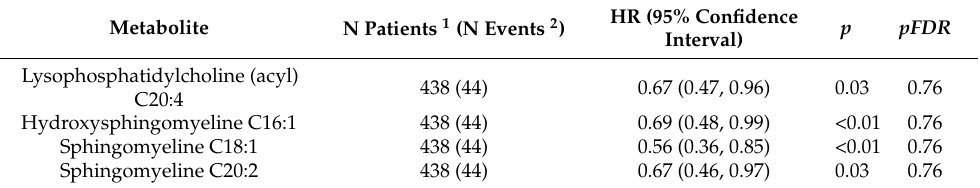
Figure 6. Forest plots of the associations of pre-surgery metabolite concentrations with risk of recurrence in prospectively followed colorectal cancer patients stratified by BMI at diagnosis. Analysis are adjusted for age, sex, tumor stage, tumor site, BMI (kg/m 2 ), and study cohort. (Hazard ratio and 95% Confidence Interval). Table 3. Associations of pre-surgery metabolite concentrations with risk of early recurrence (recur- rence occurred within 24 months after diagnosis) in prospectively followed colorectal cancer